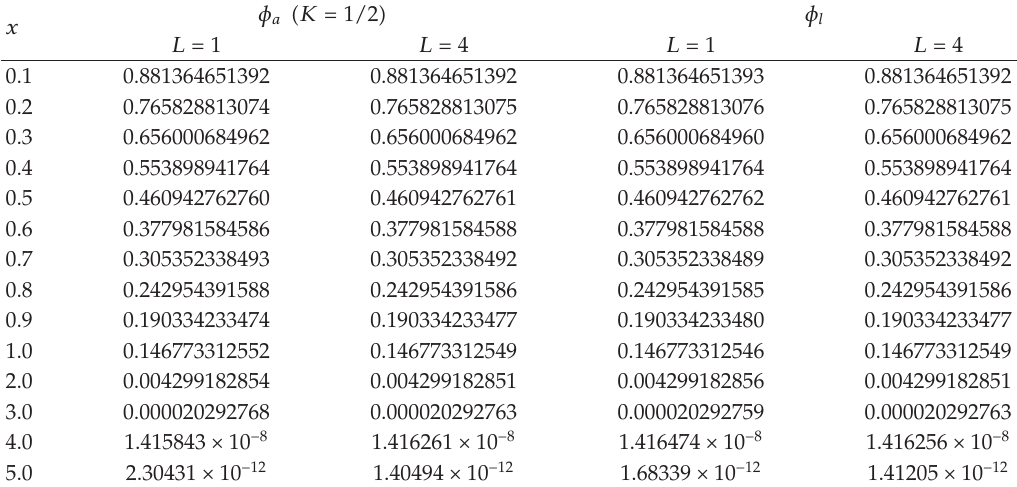
Table 5: Approximate values of y (cid:4) x (cid:3) for Example 4.3 obtained using the present method with N (cid:9)